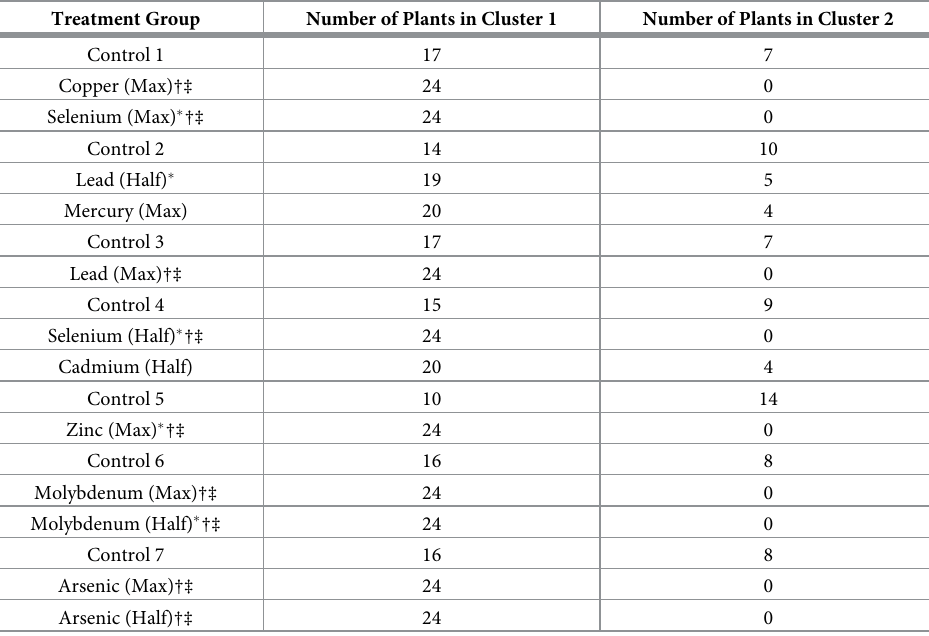
Table 4. Results of the cluster analysis reported in Section